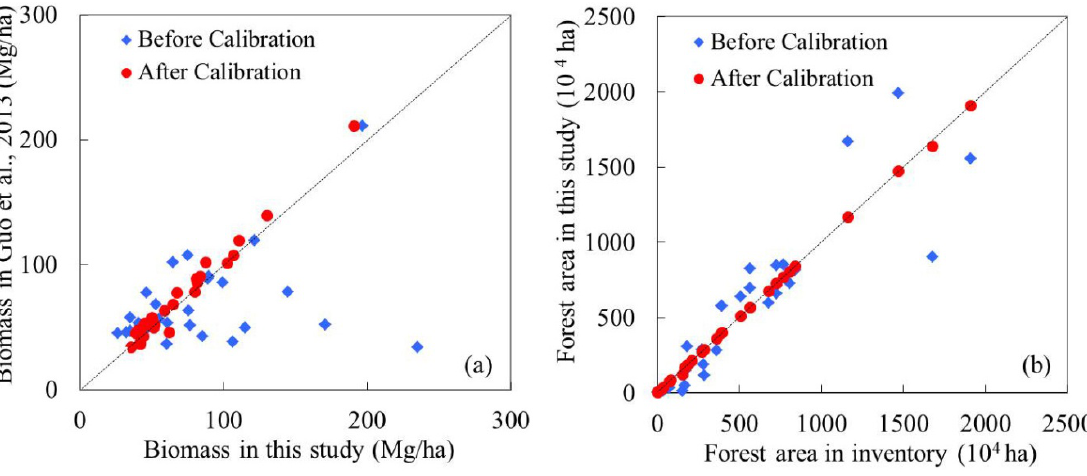
Figure 9. Accuracy assessment. ( a ) Comparison of forest biomass in the present study and in the literature; ( b ) Comparison of forest area before and after the